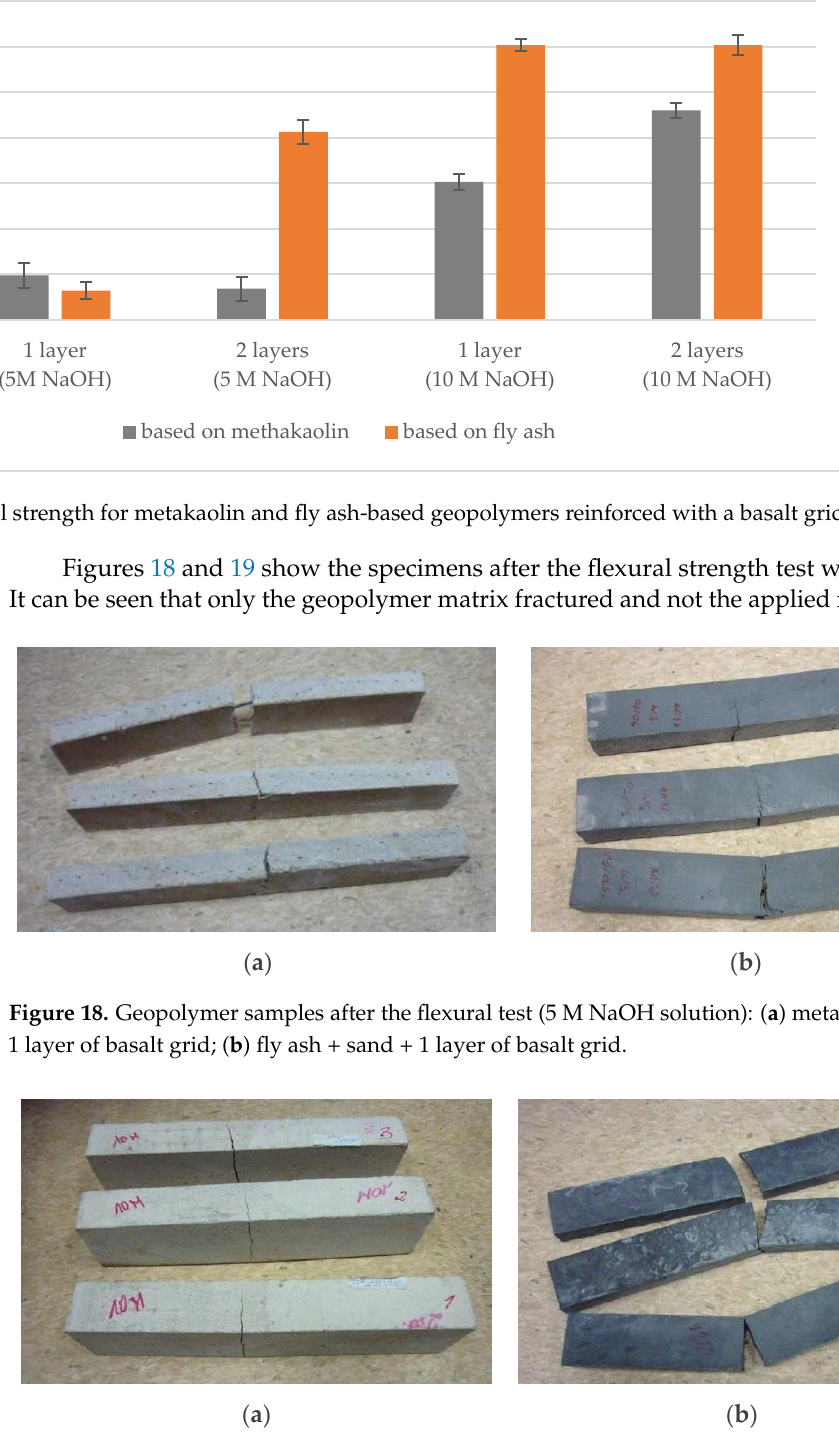
Figure 19. Geopolymer samples after the flexural test (10M NaOH solution): ( a ) metakaolin + sand + 1 layer of basalt grid; ( b ) fly ash + sand + a layer of basalt grid.